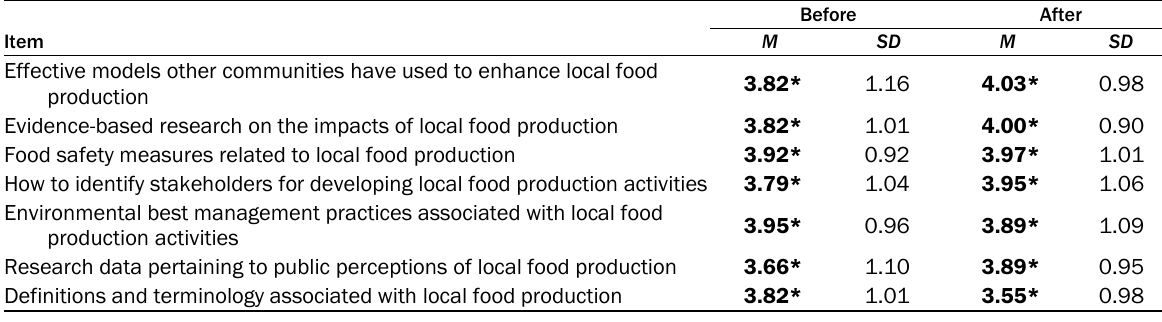
Table 15. Usefulness of Informational Needs Before and After COVID-19 ( n =38)